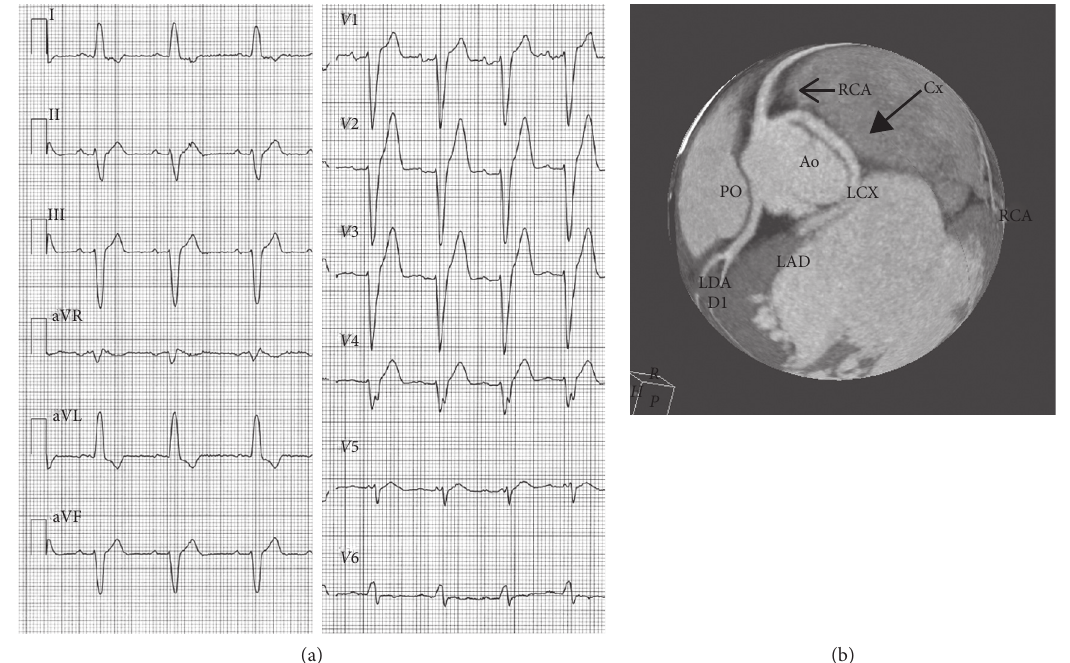
Figure 1: Male, soccer player. LBBB with left axis deviation discovered by chance at the age of 19 years. An ECG performed 2 years earlier was normal. The echocardiogram was normal. CTcoronary angiography (performed at the age of 22 years) shows the left circumflex (CX) artery arising from the right coronary sinus, close to the right coronary artery (RCA). The CX runs back to the aorta.